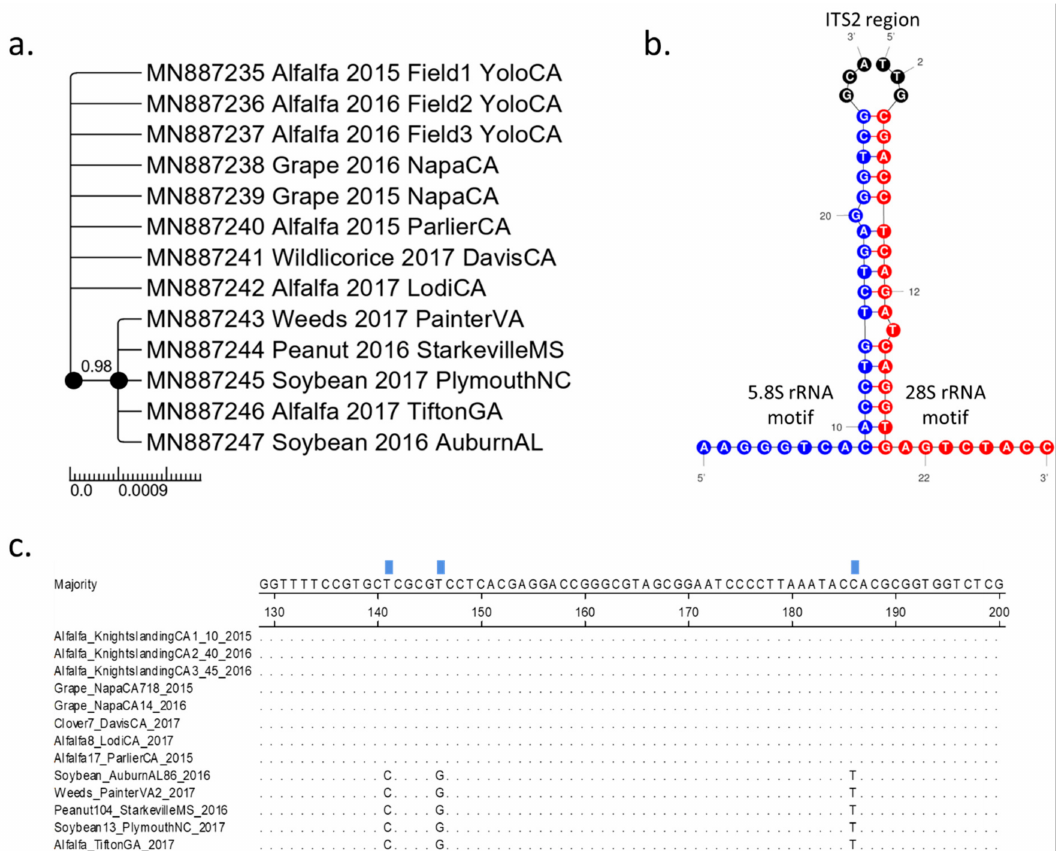
Figure 2. Analyses of internal transcribed spacer 2 (ITS2) sequences (495 nucleotides) from Spissistilus festinus populations collected from various locations, years, and crops in California and the Southeastern United States. ( a ) Phylogeny produced by Bayesian inferential analysis (with posterior probability indicated at the node) with the crop, location, and year of collection indicated in the node names. Black dots at nodes indicate bootstrap support of at least 80%, through Maximum Likelihood analysis (1000 bootstrap replicates). ( b ) Depiction of 5.8S (blue) and 28S (red) motifs denoting the boundaries of the ITS2 region (black) used as a nuclear marker for genetic variation among populations of S. festinus . ( c ) Segment of MUSCLE alignment of ITS2 sequences in which three nucleotide di ff erences at positions 141, 146, and 186 were observed between S. festinus specimens from California and the Southeastern United